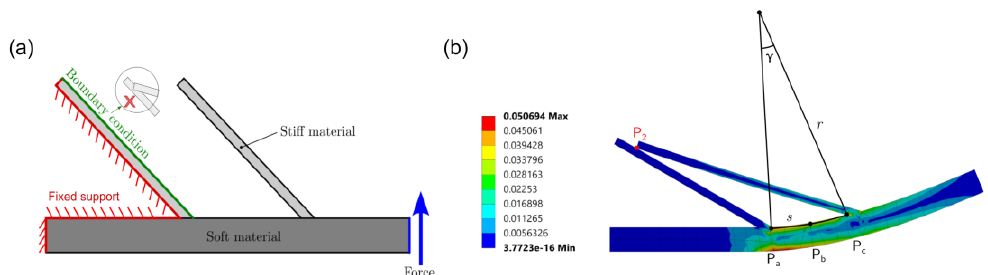
Figure 3. Fish scale model in FEA. ( a ) A schematic to show the FEA simulation setup including the material properties and boundary conditions. ( b ) FEA solution of equivalent strain with relevant points ( 𝑃 𝑎 , 𝑃 𝑏 , 𝑃 𝑐 ) and dimensions (𝛾, 𝑠) for the calculation of the radius of curvature (𝑟) .The color bar represents the elastic strain of the model.